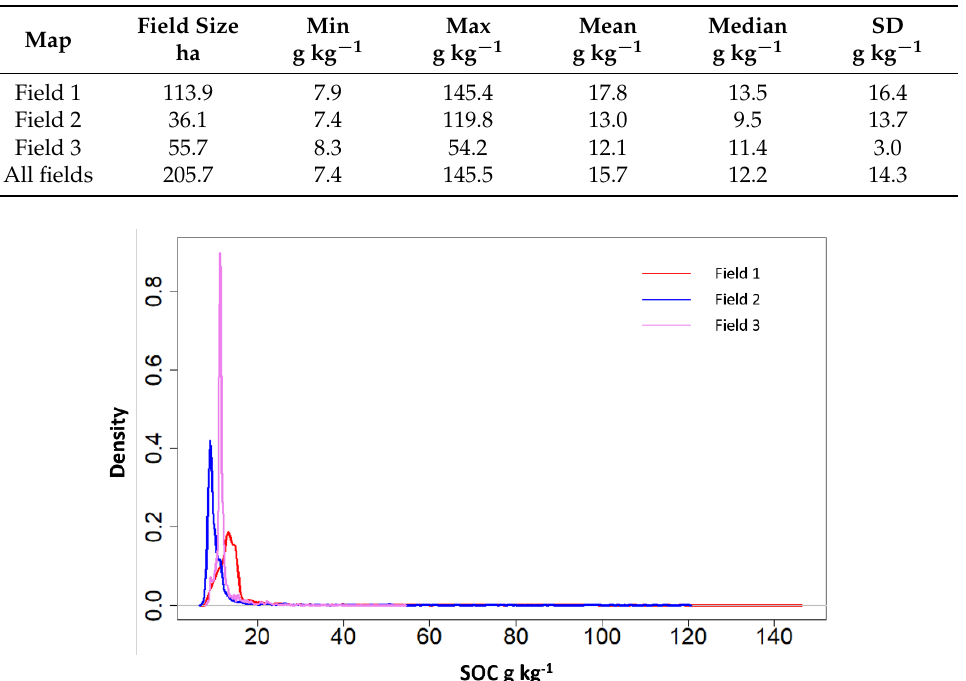
Figure 4. Kernel density estimate plot for the SOC values of field 1, 2 and 3 adapted from [34].